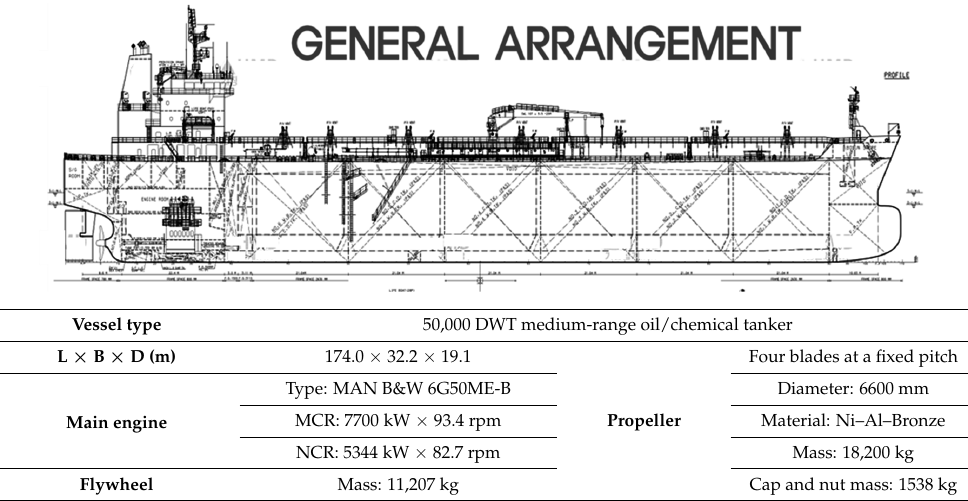
Table 1. General arrangement and specifications of the case study ship (courtesy of the shipyard).